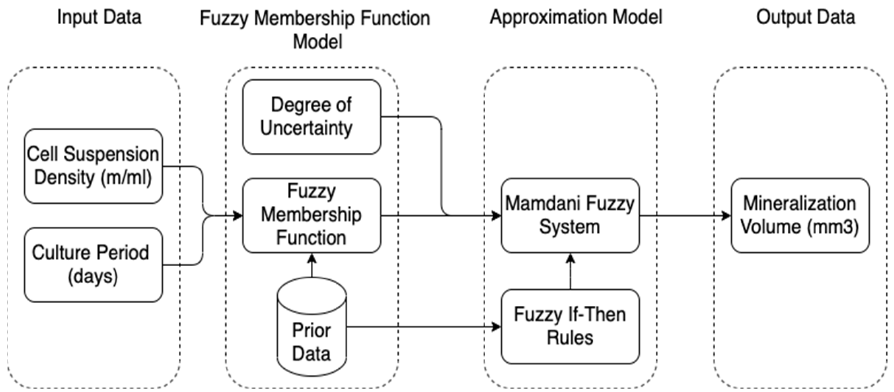
Figure 2. Schematic of our study design optimization technique, with two inputs (cell suspension density and culture period) and one output (mineralization volume).